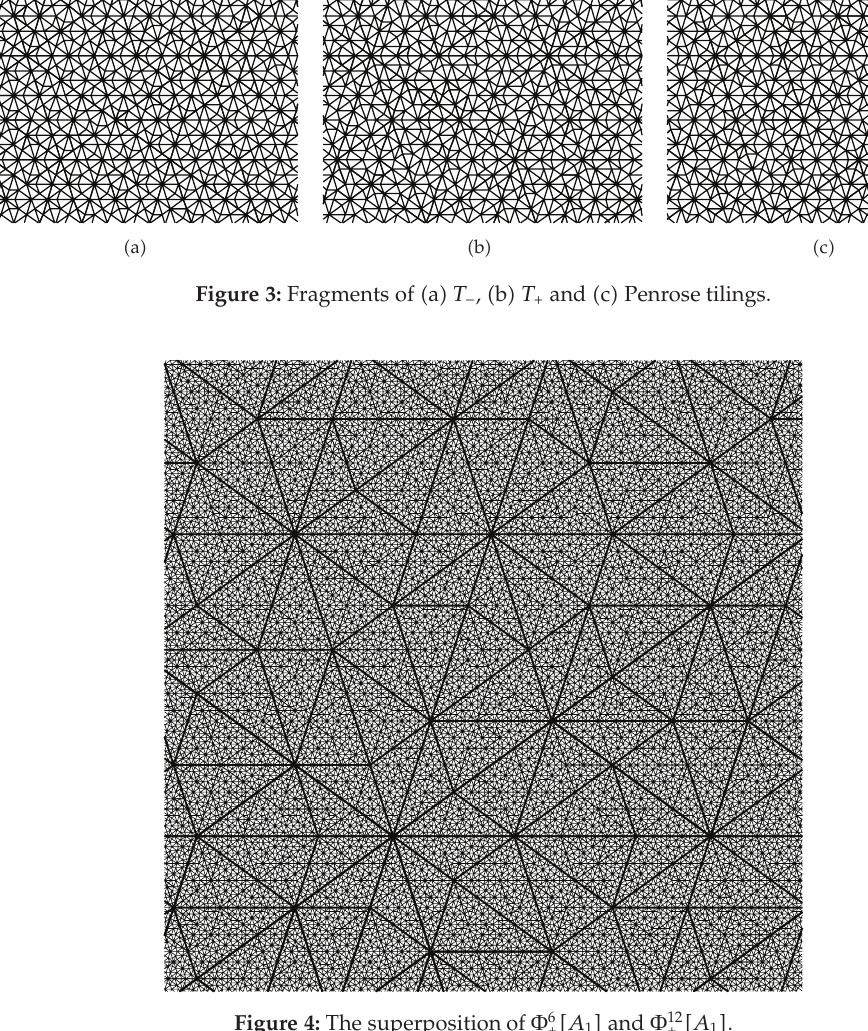
Figure 4: The superposition of Φ 6 (cid:8) (cid:2) A 1 (cid:3) and Φ 12 (cid:8) (cid:2) A 1 (cid:3)